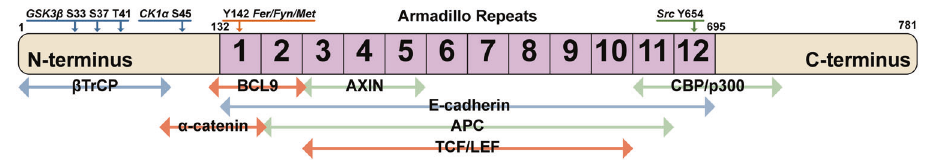
Fig. 4 The structural illustration of human β -catenin protein. In this fi gure we mainly demonstrated the important PPI binding domains and phosphorylation sites of β -catenin. This image was modi fi ed from a published research.